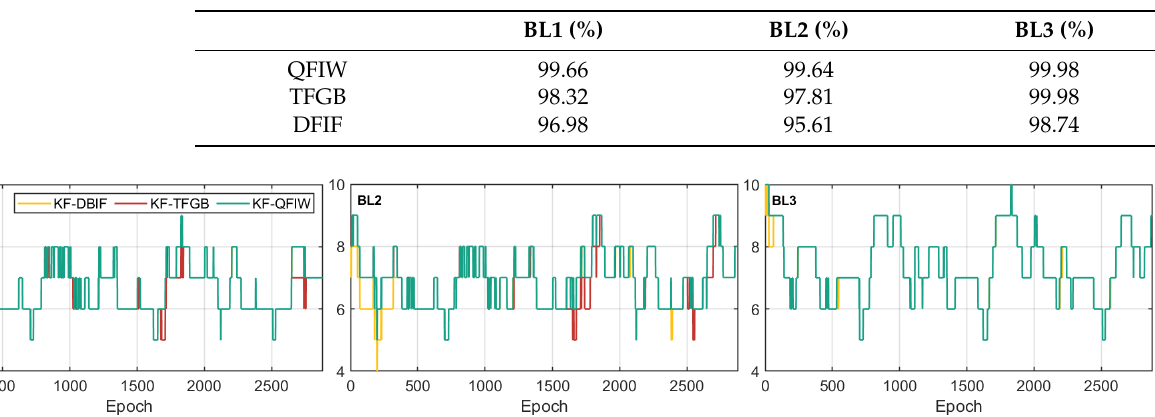
Figure 8. Basic float ambiguity bias for three baselines calculated by QFIW, TFGB, and DFIF models. Table 4. Statistics of basic ambiguity resolution success rate.